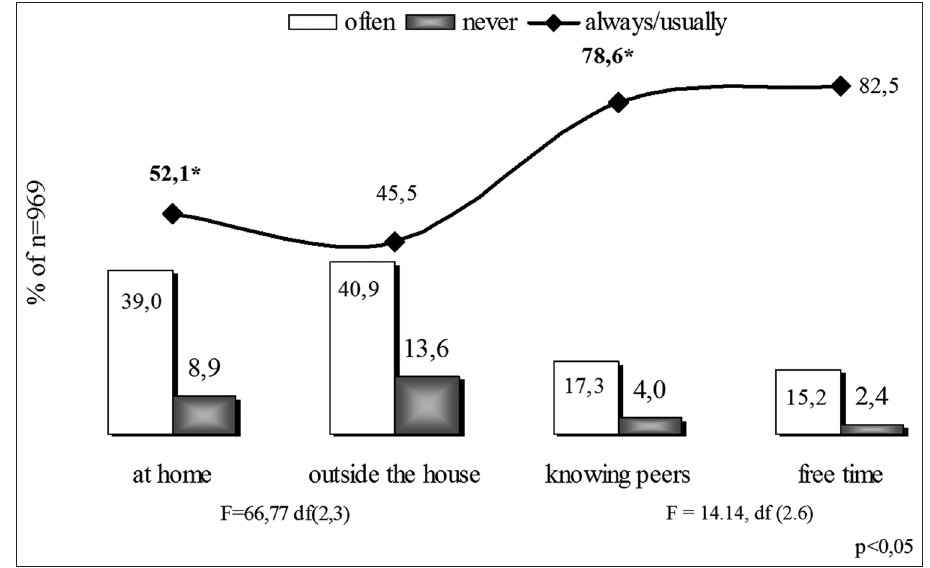
FIGURE 3. The perception of family rules and knowledge by